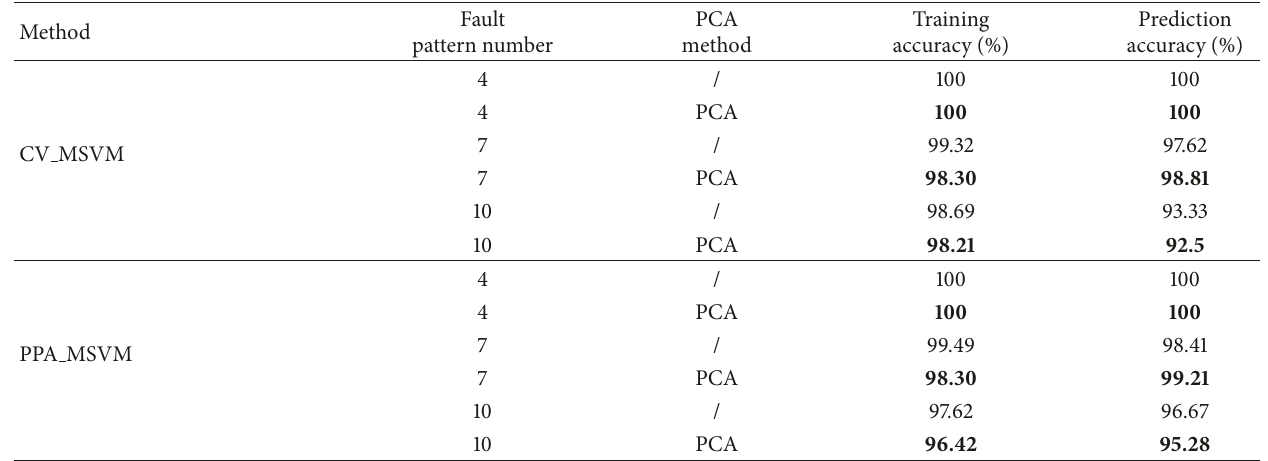
Table 6: Comparison of the performance of recognizer in different fault